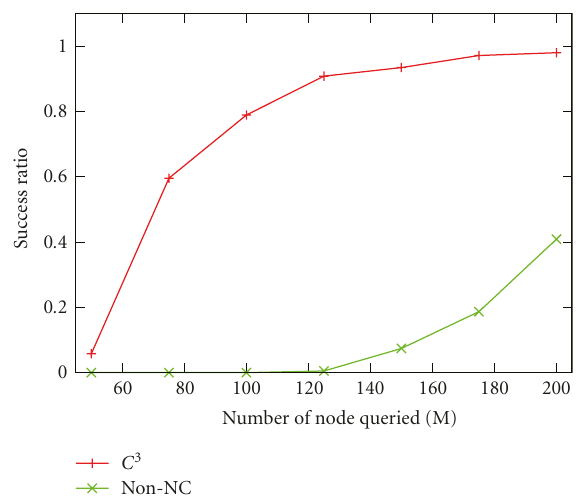
Figure 5: Success ratio as a function of M for C 3 and Non-NC.